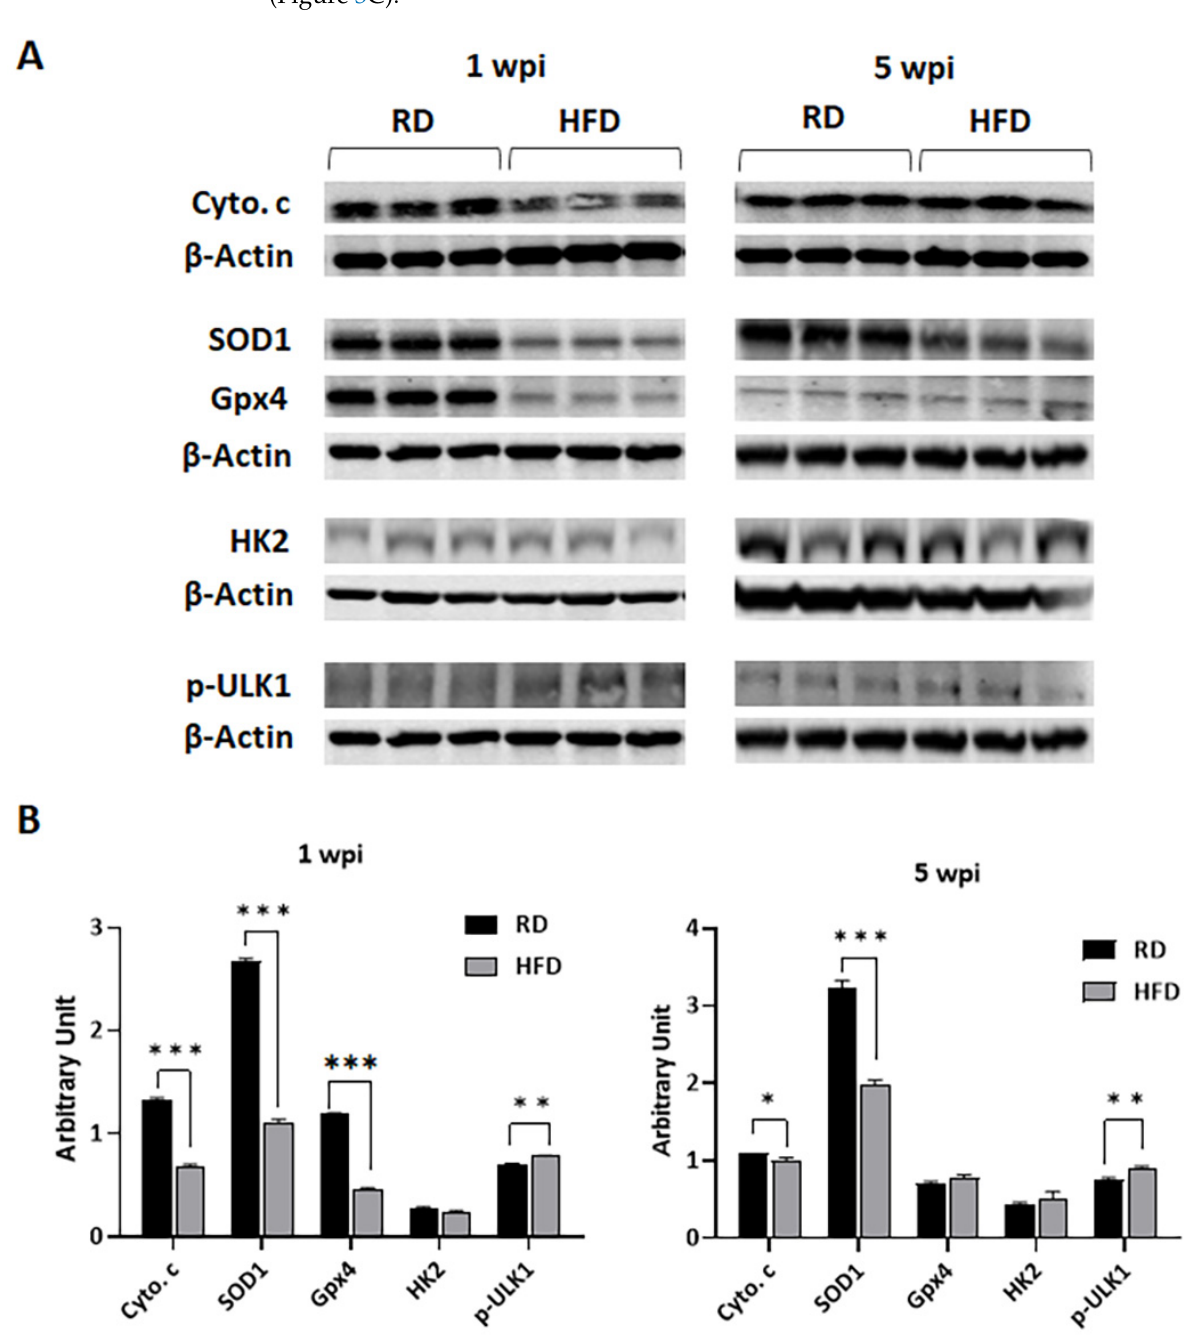
Figure 6. RD and HFD differently regulate the expression levels of markers of mitochondrial β - oxidation (cytochrome c and SOD1), glycolysis (HK2), and autophagy (p-ULK1) in tumor-associated mammary fat pads during early (1 wpi) and later (5 wpi) time points of tumor growth in young female E0771 tumor-bearing mice. ( A ) Immunoblots showing different protein expression levels between RD and HFD at 1 wpi and 5 wpi. β -Actin was used as loading control. ( B ) Bar graphs showing the levels of each protein marker normalized to β -Actin (left panel—1 wpi; right panel—5 wpi). The error bars represent the standard error of the mean. * p < 0.05, ** p < 0.005, and *** p ≤ 0.001.